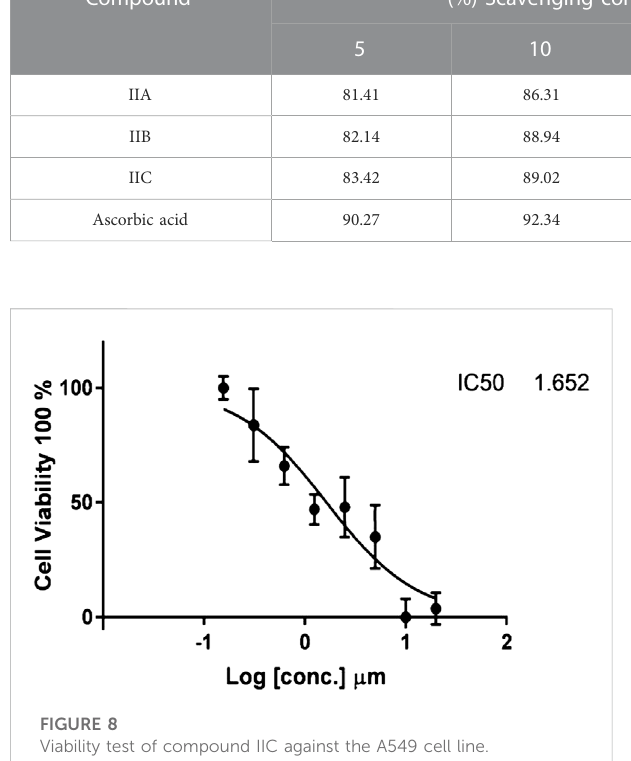
TABLE 6 Results of antioxidant activity of the three derivatives against DPPH free radical.